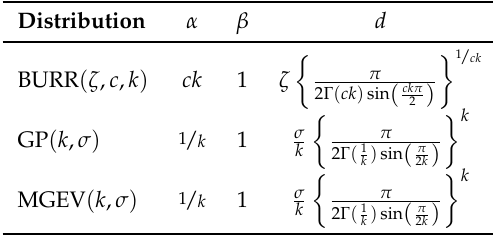
Table 2. Values of α , β and d for the selected severity